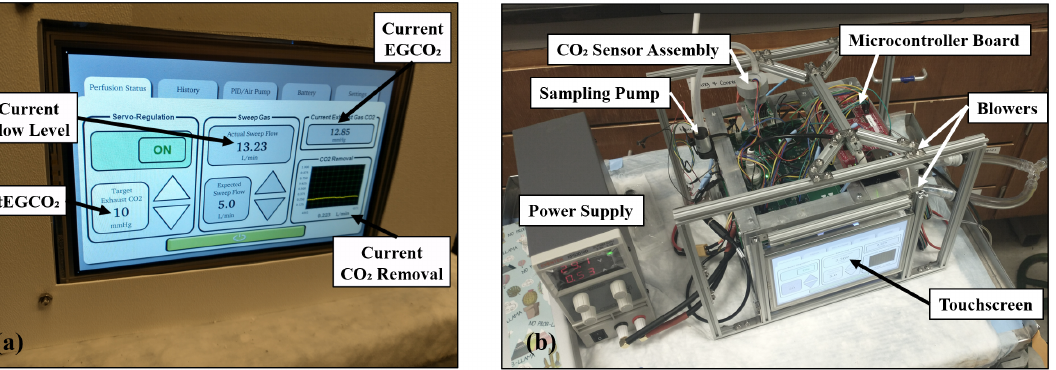
Figure 5. Photographs showing portable servoregulation controller ( a ) with enclosure and ( b ) without the enclosure.